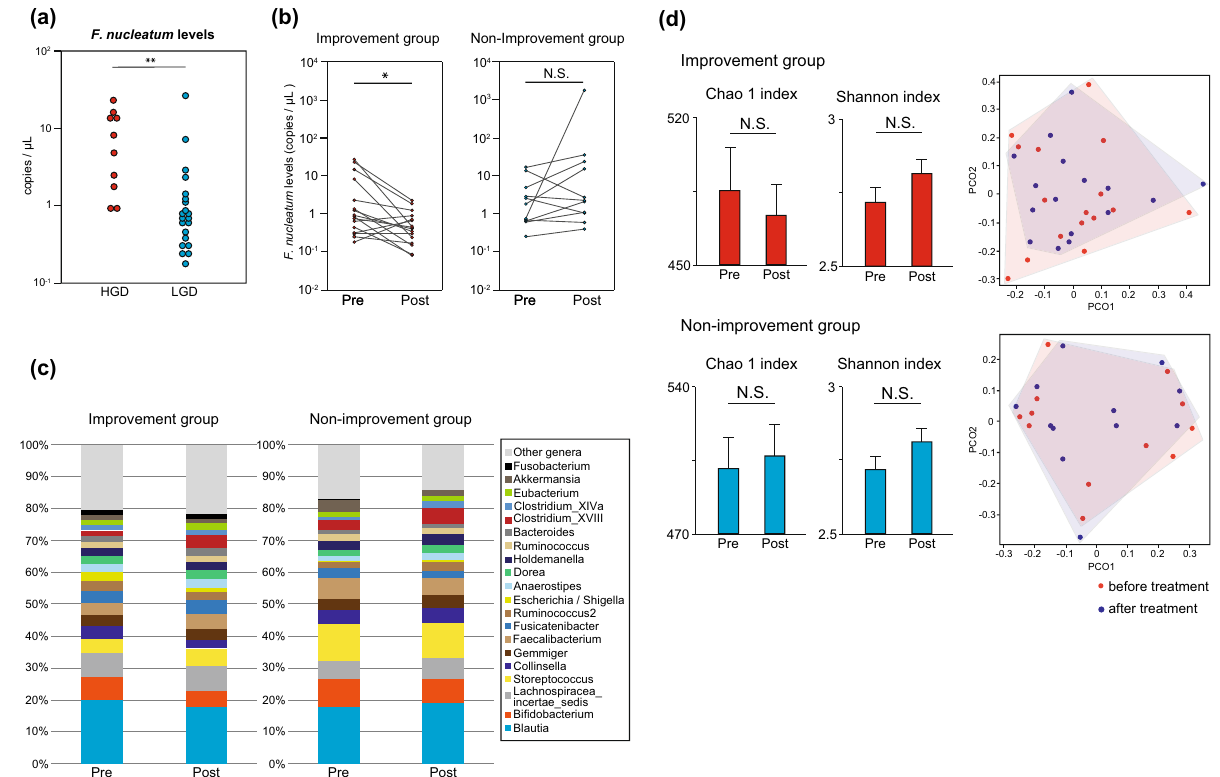
Figure 3. Analysis of Fusobacterium nucleatum DNA levels and bacterial flora in the stool. ( a ) F. nucleatum DNA levels in the stool before periodontal treatment (n = 10, 21). HGD, high-grade dysplasia; LGD, low-grade dysplasia. ( b ) F. nucleatum DNA levels in the stool of patients before and after periodontal treatment (n = 16, 11). ( c ) Changes in the bacterial composition of the stool before and after treatment for periodontitis. ( d ) Changes in the diversity of faecal bacterial flora. Data are means ± SEM. *p < 0.05, **p < 0.01, Wilcoxon rank-sum test ( a ), paired Student’s t -test ( b , d ), PCoA analysis with the R Software ( d